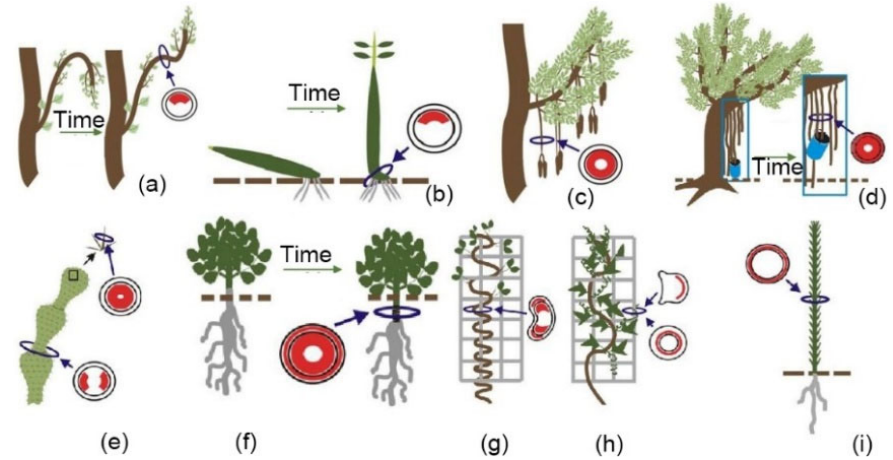
Figure 8. Distribution of reaction tissues (red areas) in various plants and organs [11]. ( a ) Branches of broad ‐ leaved trees [68,69]; ( b ) stem of mangrove seedlings during gravitropic movement [70]; ( c ) pedicles of heavy fruits [63]; ( d ) Aerial roots [64]; ( e ) spines and cladode junction regions of Opuntia [71,72]; ( f ) roots and hypocotyls of geophytes [63,71]; ( g , h ) stems and tendrils of scandent and climbing plants [65,73]; ( i ) stems of fiber crops [64,72].